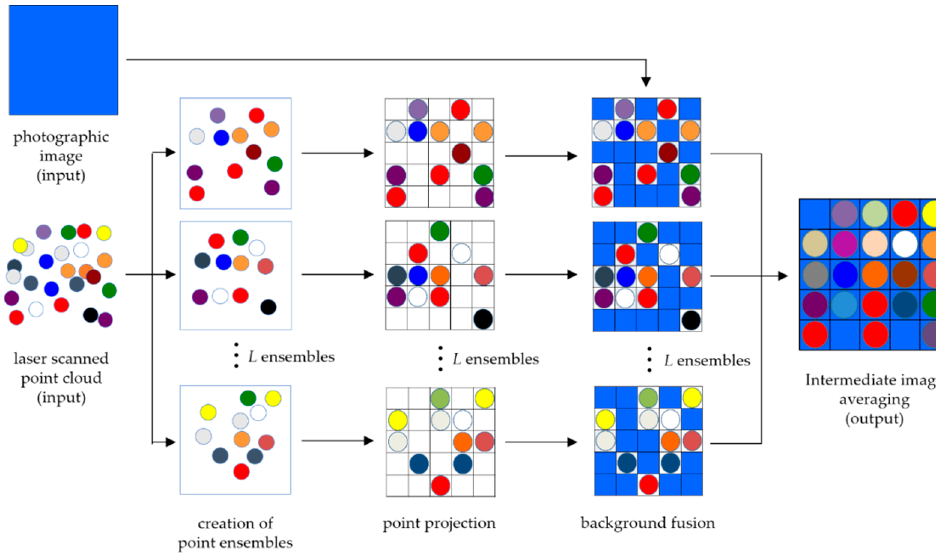
Figure 1. Scheme of the proposed fused transparent visualization.